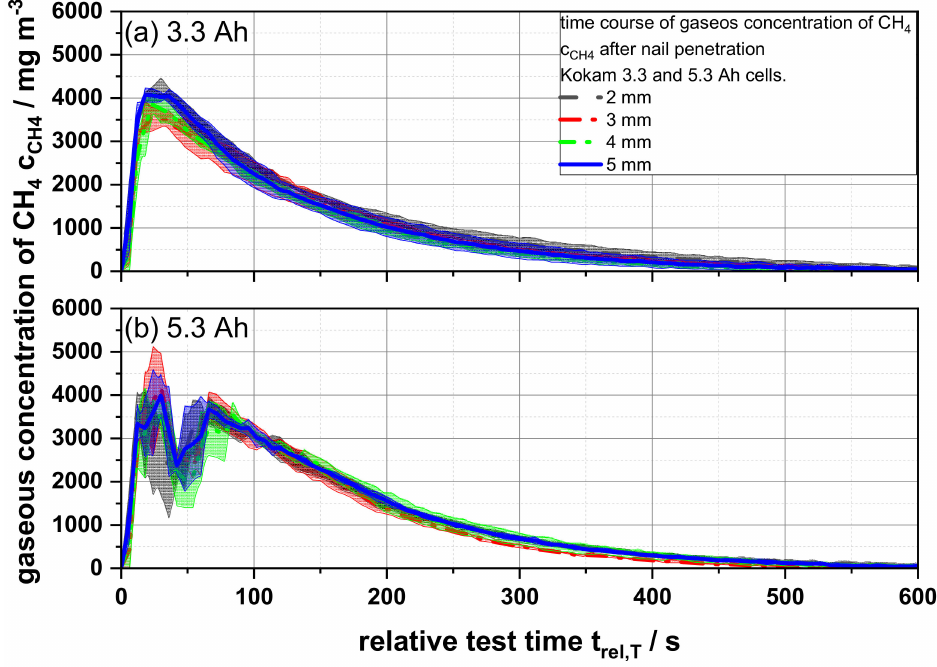
Figure 5. Average gaseous concentrations of methane c CH4 as a function of the relative test time t rel,T of ( a ) 3.3 and ( b ) 5.3 Ah cells for different nail geometries from 2 to 5